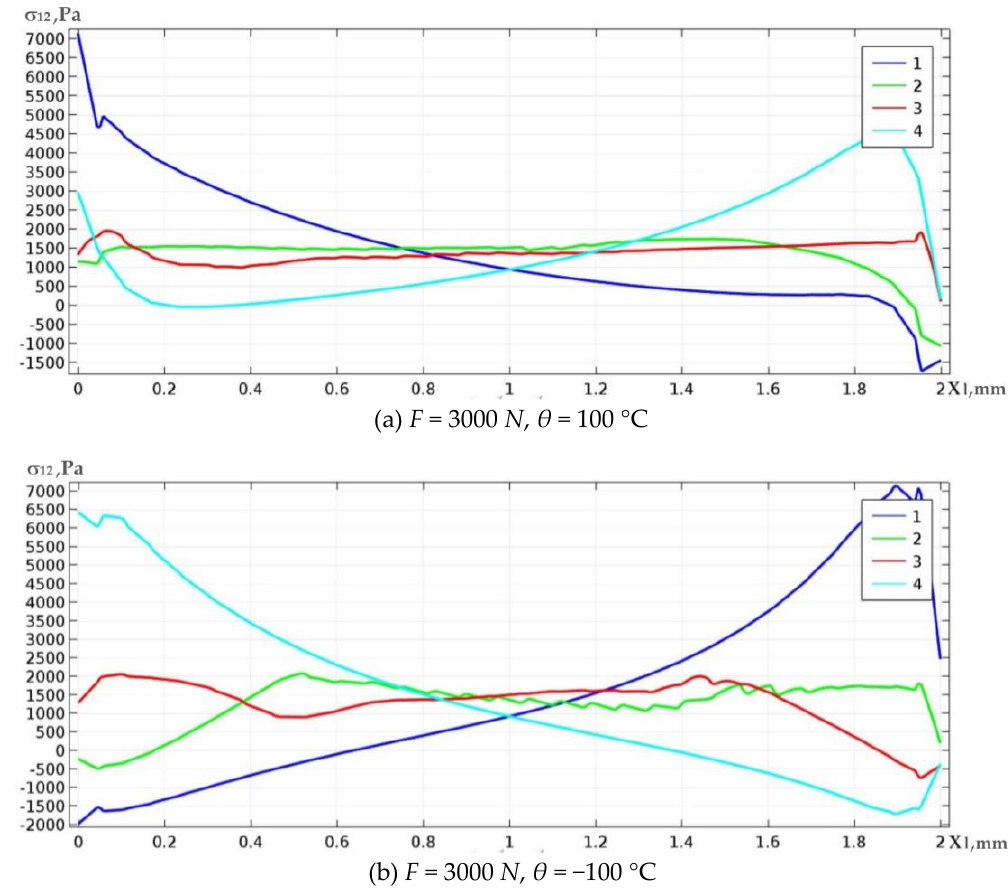
Figure 12. Graphs of the distribution of shear stresses along the upper (1, 2) and bottom (3, 4) boundary of the solder area under simultaneous action of both mechanical (positive ( a ) and negative ( b ) thermal loads.